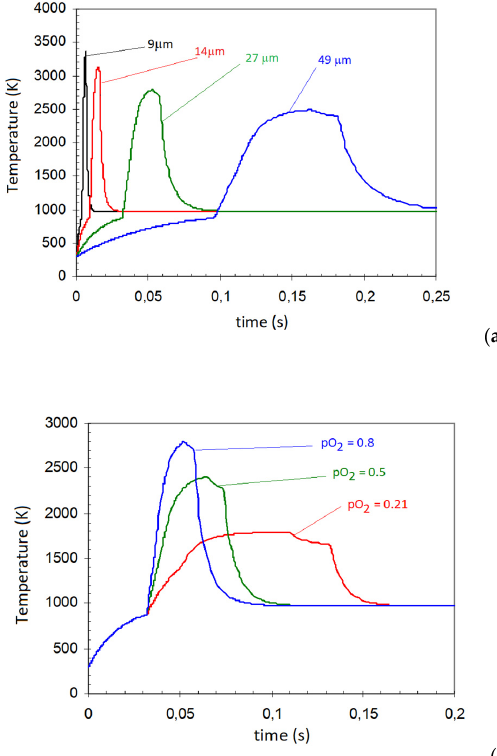
Figure 2. Temperature evolution for different sizes of CuFeS 2 (chalcopyrite) particles with different pO 2(g) in the process gas. The temperature of the environment was set at 973 K (700 °C). ( a ) pO 2(g) = 0.8; ( b ) size of particle = 27 μ m.